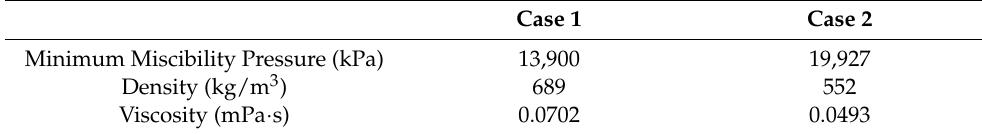
Table 9. Minimum miscibility pressures (MMPs) calculated using the slim-tube method with pure and impure CO 2